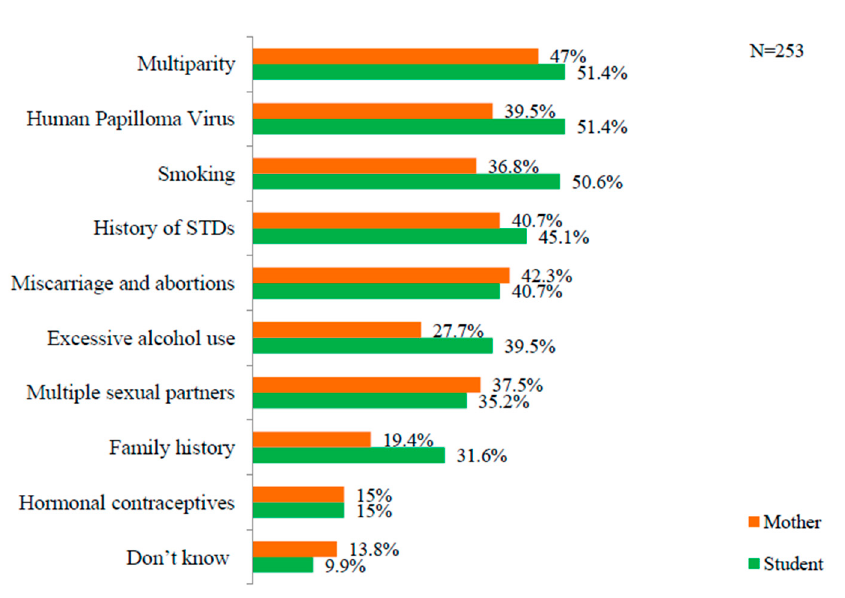
Figure 1. Knowledge of mothers and students about the risk factors of cervical cancer.